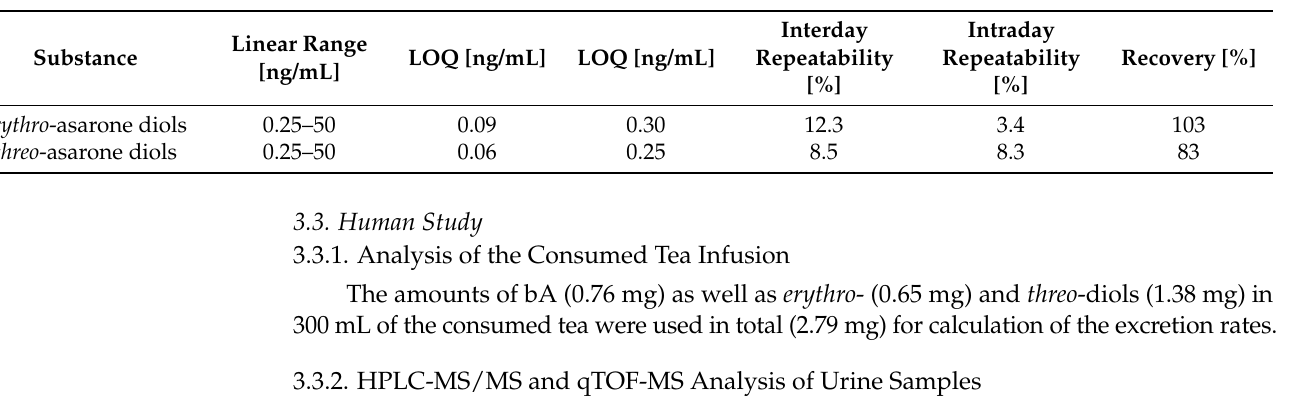
Table 1. Method performance characteristics of the LC-MS/MS method used for quantitation of erythro - and threo -asarone diols in urine samples.